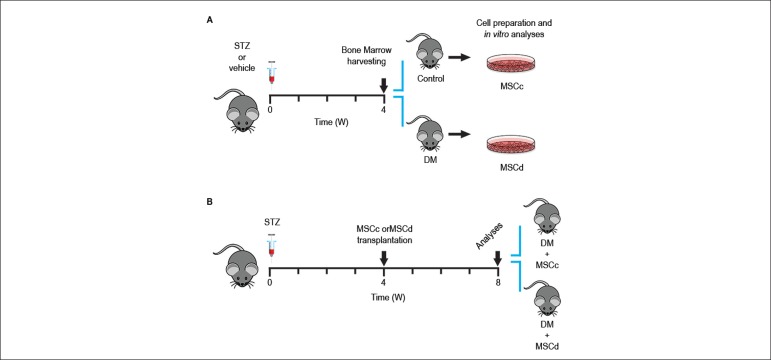
Experimental study design. (A) Animals were treated with vehicle and
streptozotocin (STZ) at week 0. Bone marrow cells were harvested on
the 4th week for culture and in vitro analyses. (B) MSC therapy
scheme. Diabetic animals (STZ) were divided into two groups: the
first one received 5 x 106 cells from healthy rats (DM + MSCc) and
the second received the same quantity of cells from diabetic rats
(DM + MSCd) after 4 weeks of disease. The cells were injected into
the animals’ retroocular plexus. Blood glucose levels and body
weight were evaluated during 4 weeks after transplantation. At the
end of the protocol, the animals were sacrificed, and their hearts
were isolated for potential recording.